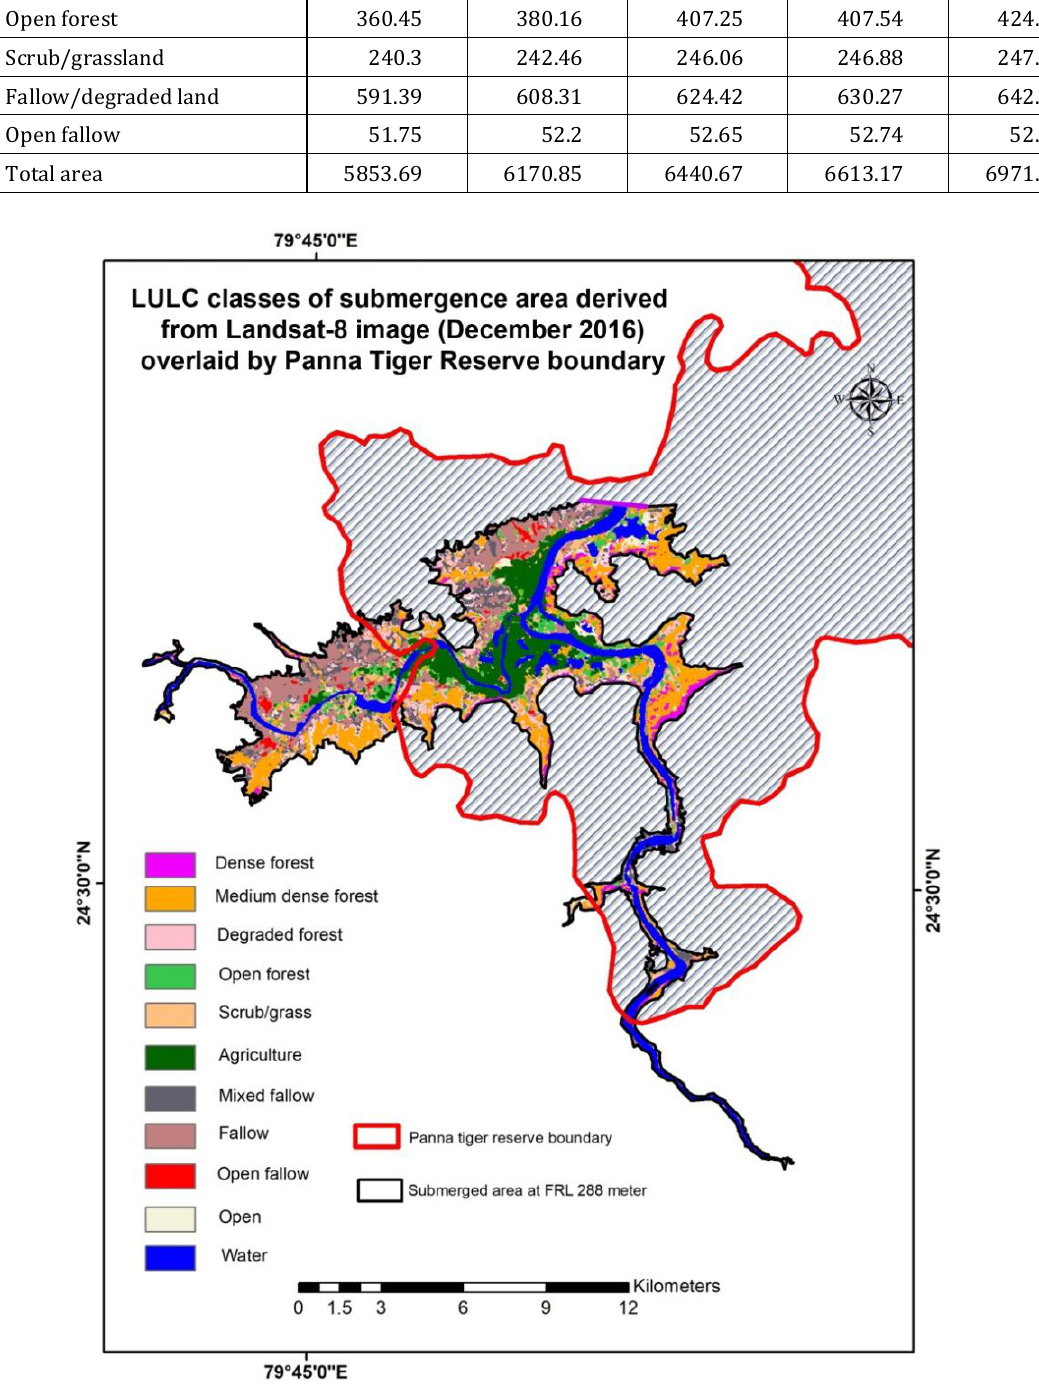
Fig. 6. LULC of submergence area in Panna Tiger